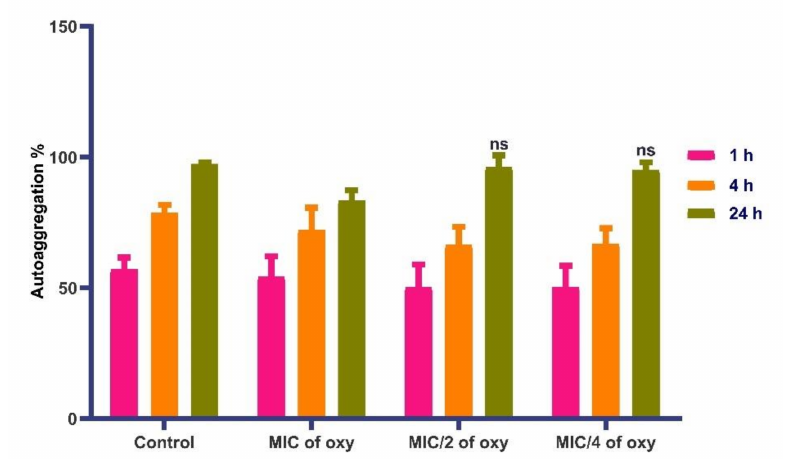
Figure 13. Autoaggregation potential of L. fermentum ASBT-2 with MIC and sub-MIC concentrations of oxyresveratrol at 1 h, 4h and 24 h of incubation. ns: non-significant.